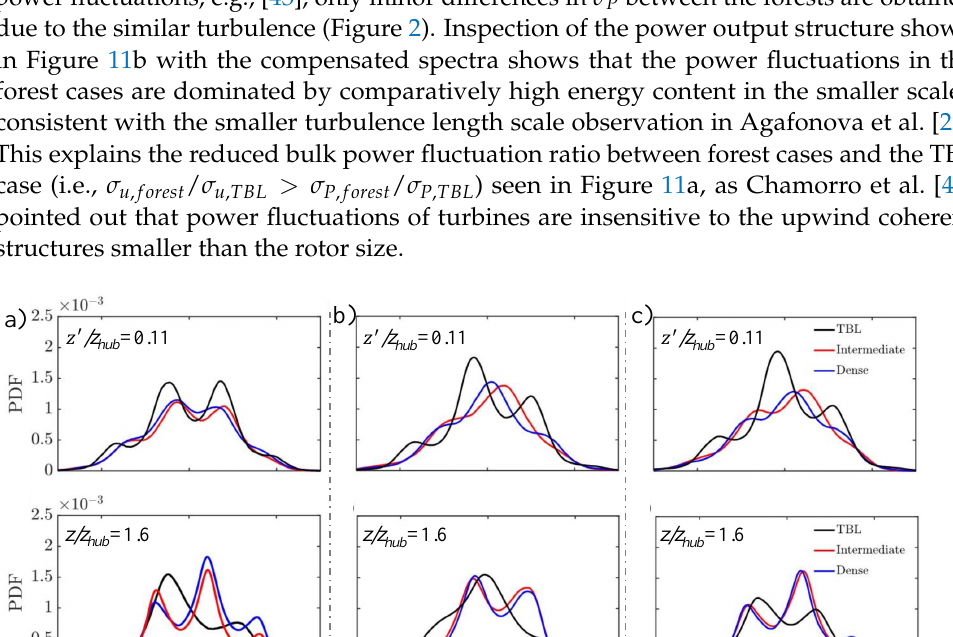
, and power output intensity, σ P / P ; hub